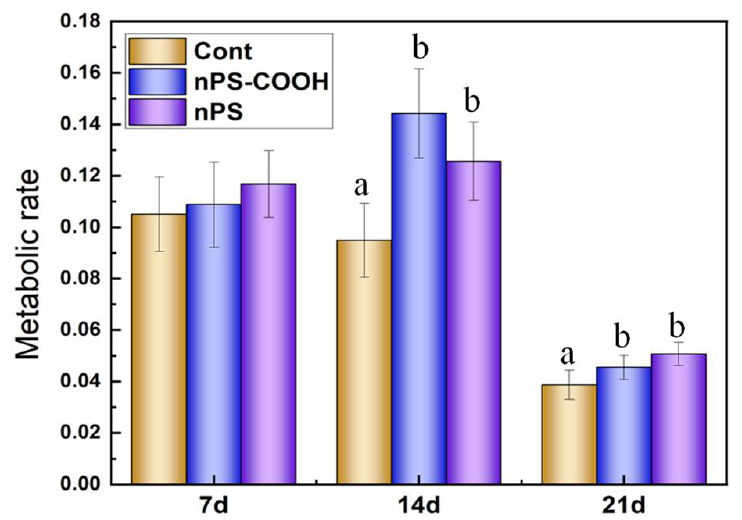
Figure 3. Comparison of carbon metabolic rate of biofilms (fitted by Equation (2) at the stable stage) exposed to PS NPs with different surface modifications at day 7, day 14, and day 21 ( n = 3). Different letters represent significant differences among the PS treatments ( p < 0.05).